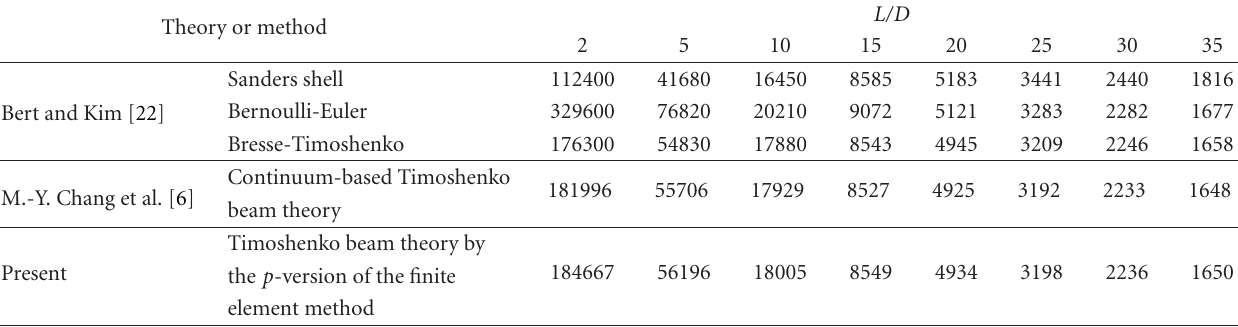
Table 4: The critical speed (rpm) of the graphite-epoxy composite shaft for various lengths to mean diameter ratio. Theory or